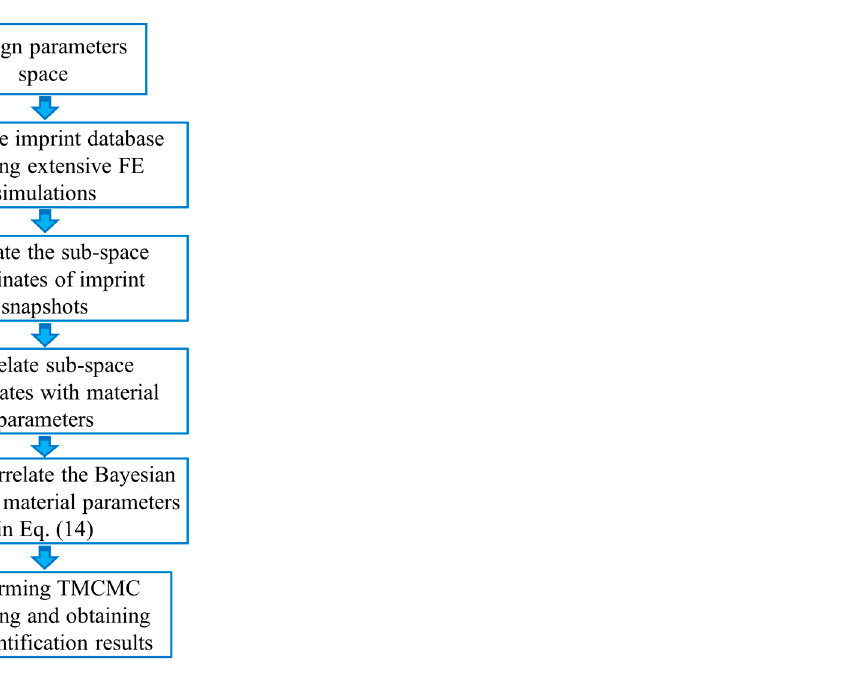
Figure 5. The basic procedures for measuring elastoplastic properties of materials using the estab- lished approach.